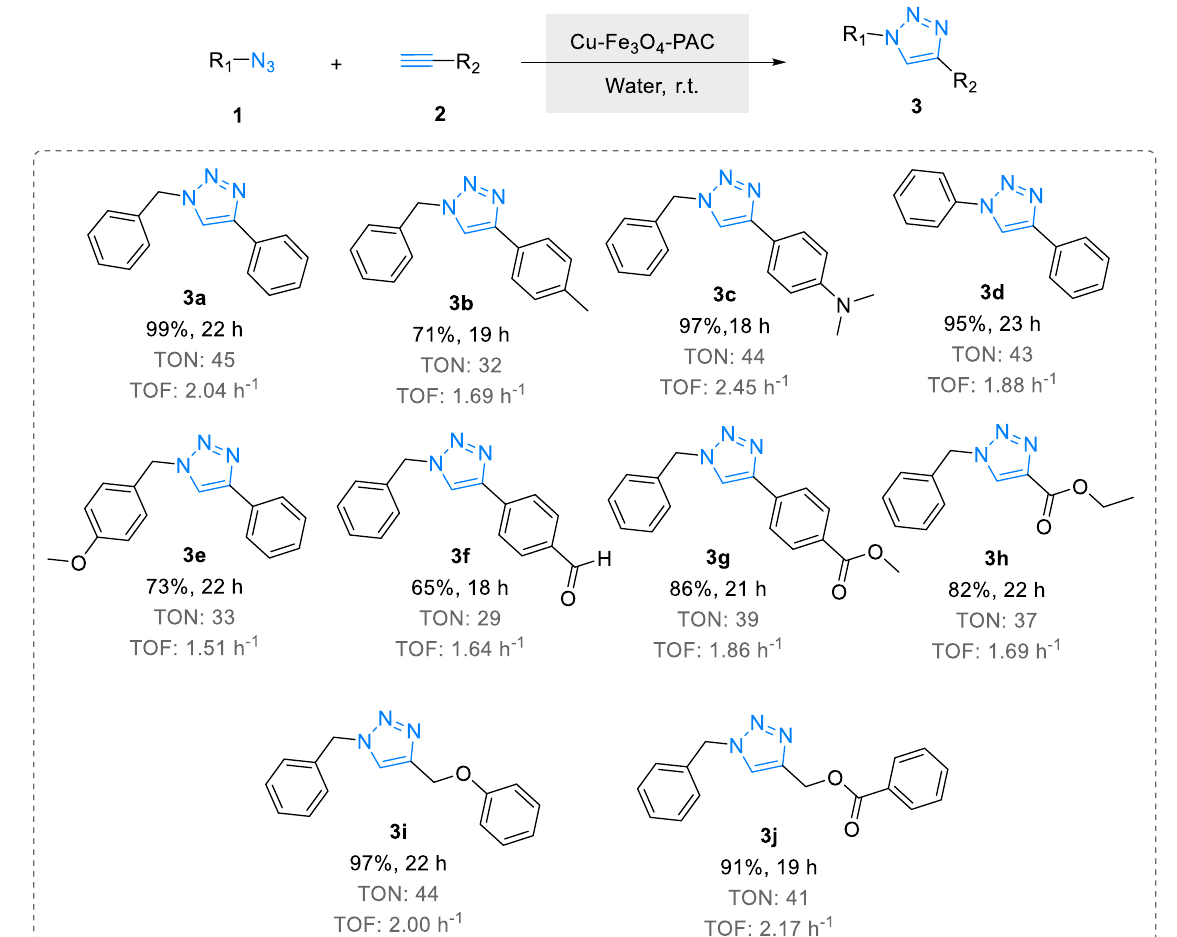
Scheme 2. Azide-alkyne [3+2] cycloaddition reactions catalyzed by Cu-Fe 3 O 4 -PAC. Abbreviations: